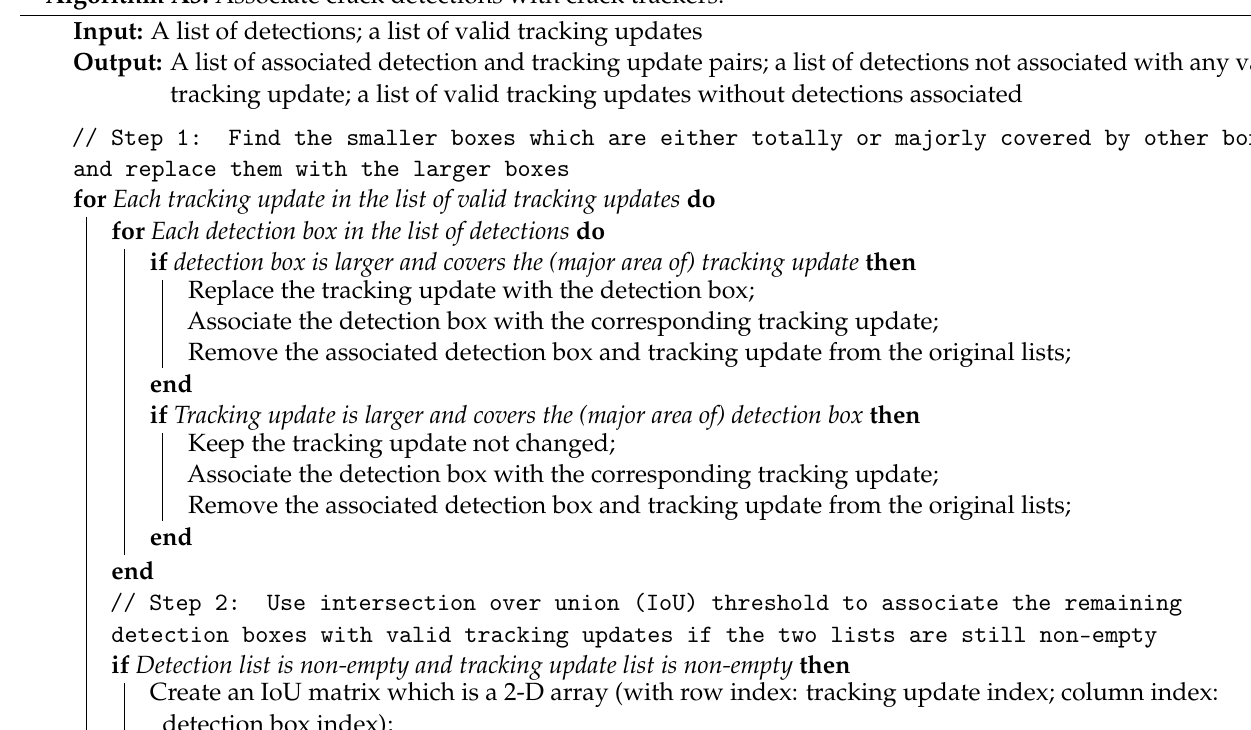
Algorithm A3: Associate crack detections with crack